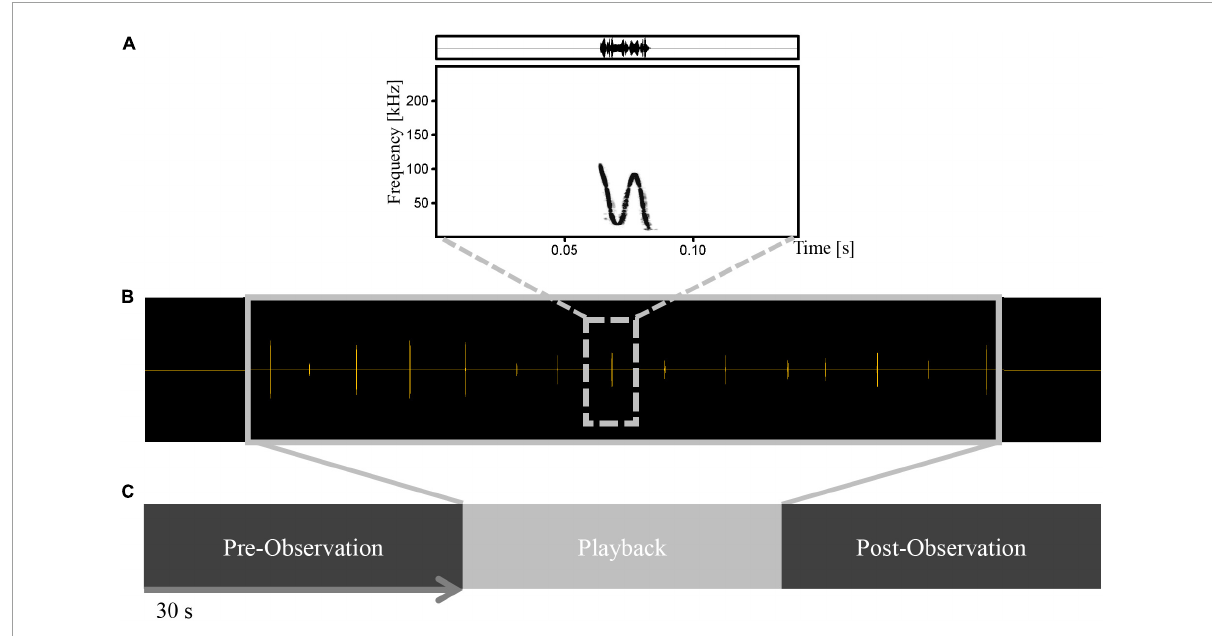
FIGURE2 For each playback sequence, 15 social calls (A) were combined into 30-s-long playback files (B) . One trial for each call type consisted of three experimental phases: Pre-observation, playback, and post-observation (C) . Pre- and post-observation phase consisted of